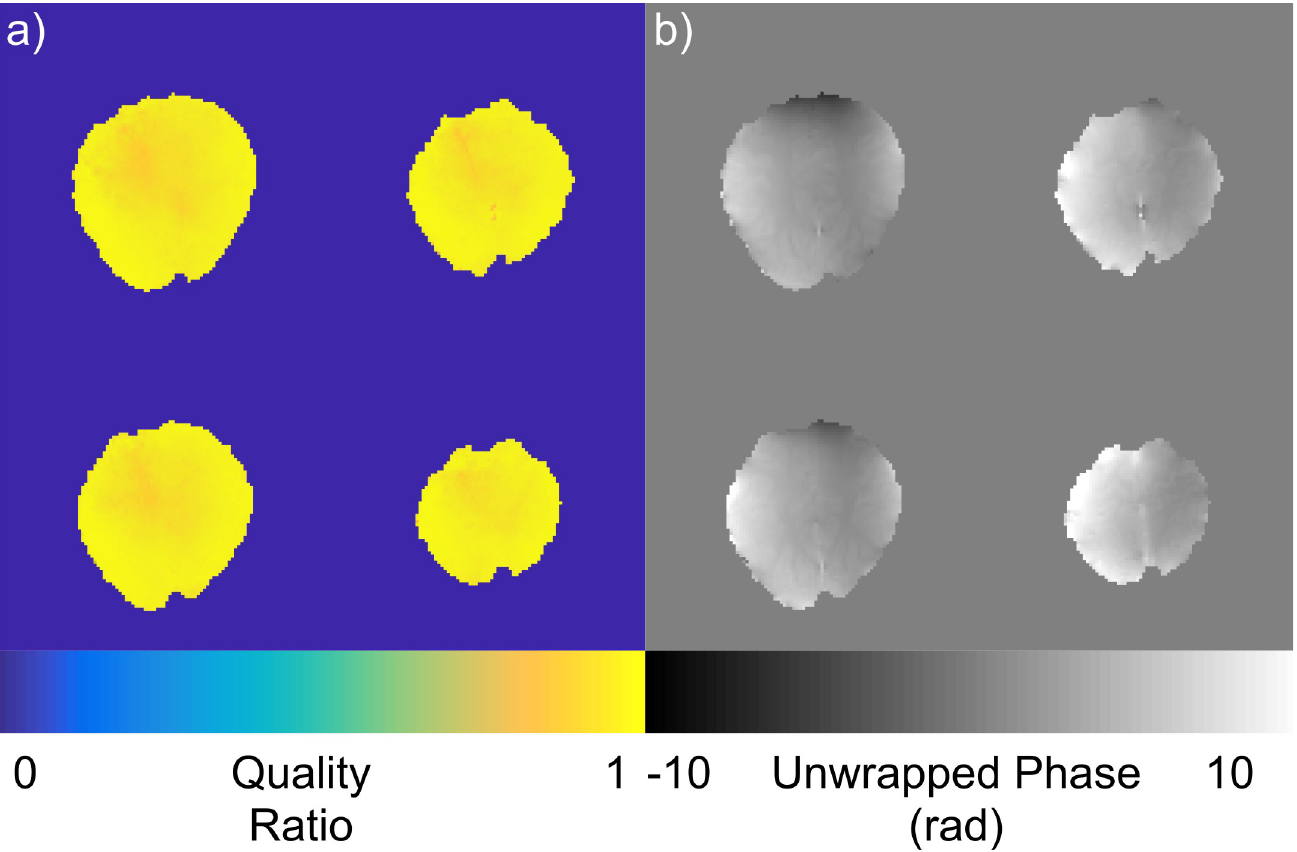
Fig 4. Combination quality of an asymmetrical coil. a) Quality ratio of data collected in an occipital parietal coil when combined with the fitted SVD method, b) Spatially unwrapped phase data after fitted SVD combination.